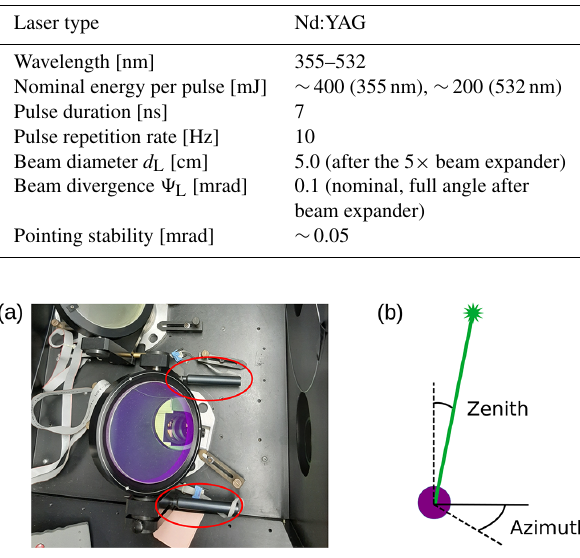
Figure 1. (a) Top view of the two 45 ◦ mirrors with azimuth and zenith servomotors (components circled in red). (b) Schematic of the mirror/beam